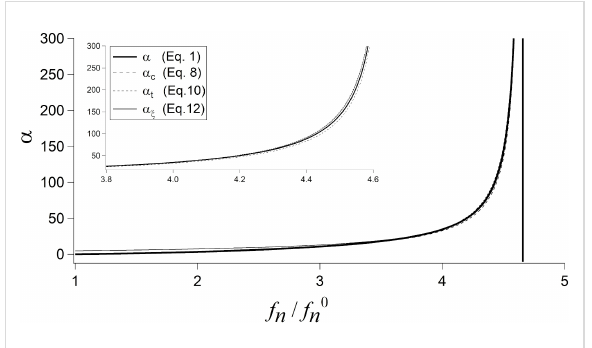
Figure 2: The function α without approximations (Equation 1) and its three approximations α c (Equation 8), α t (Equation 10), and α ξ (Equa- tion 12). The inset shows in detail the range 3.8 < f n / f n 0 <